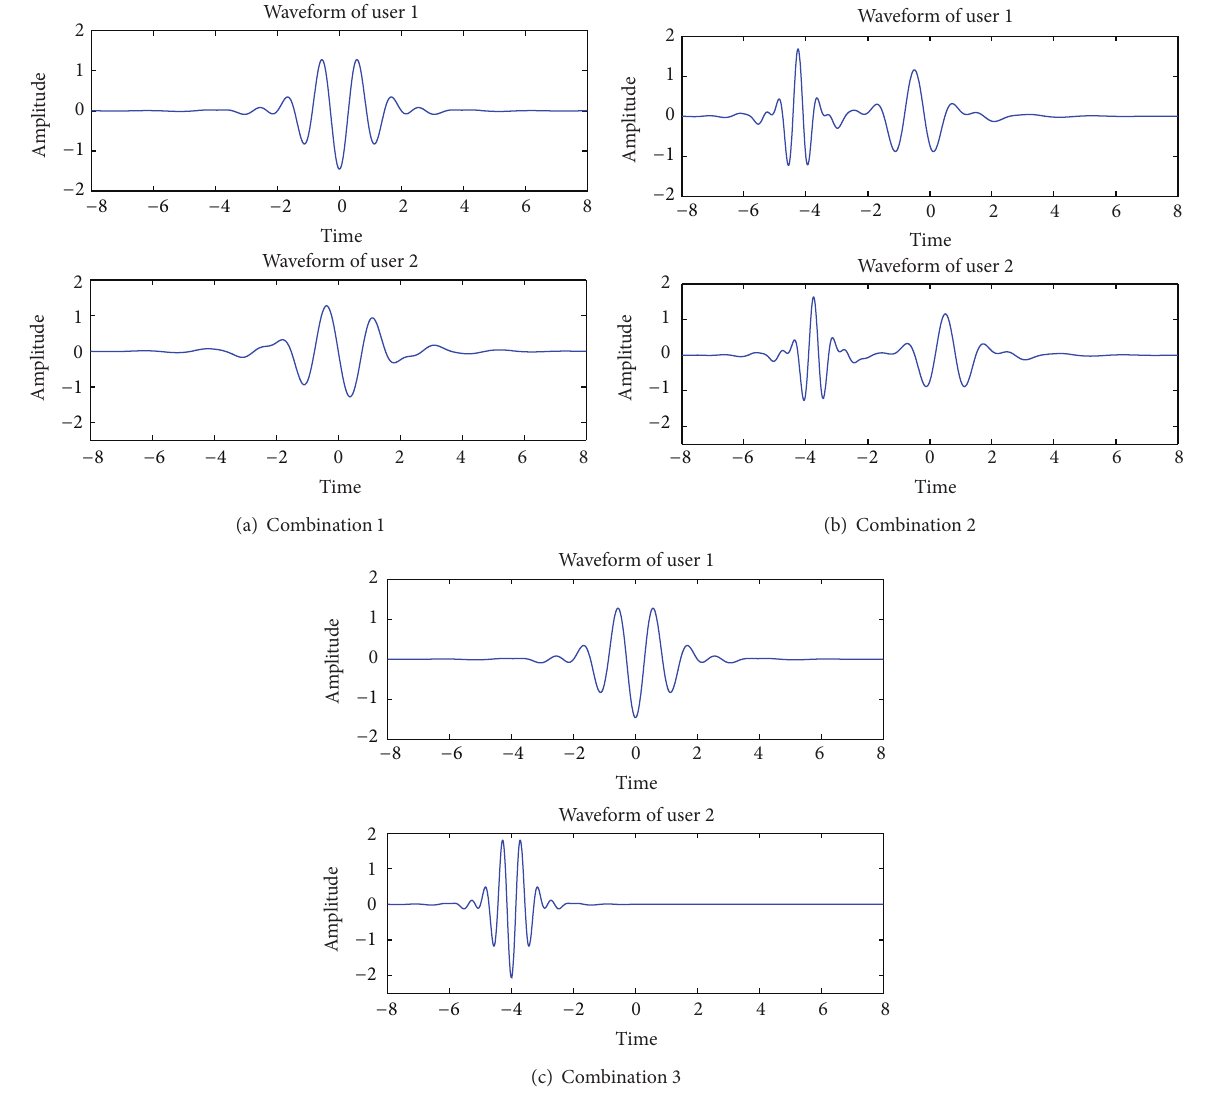
Figure 4: Waveforms of three combination modes.